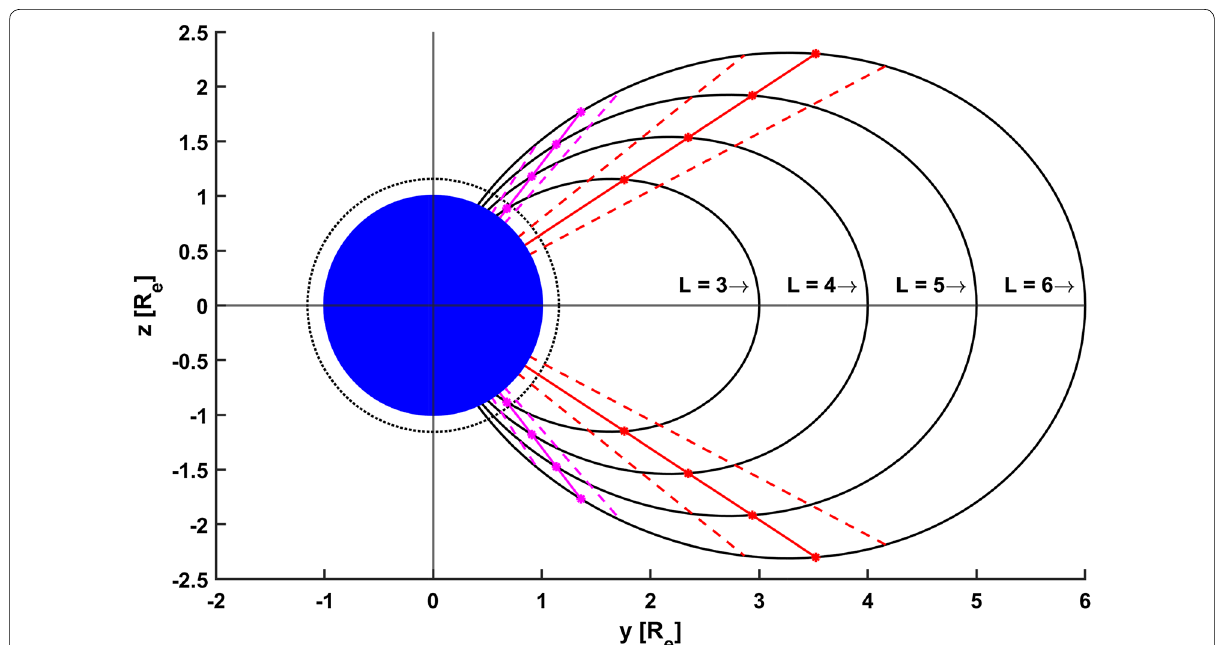
Fig. 3 Illustration of the dipolar magnetic field lines of the Earth in the Geocentric Solar Ecliptic coordinate system. The Earth’s centre is at the origin [0 0 0], and the magnetic field lines corresponding to L = 3 to 6 are shown. The solid red and magenta lines correspond to the theoretical magnetic mirror points with the equatorial pitch angle of 30 ◦ and 10 ◦ , respectively. The dotted lines correspond to the maximum deviation observed in the simulation with theoretical estimates of magnetic mirror point latitude. The dotted black circle represents the upper boundary of the ionosphere at 1000 km above the surface of the